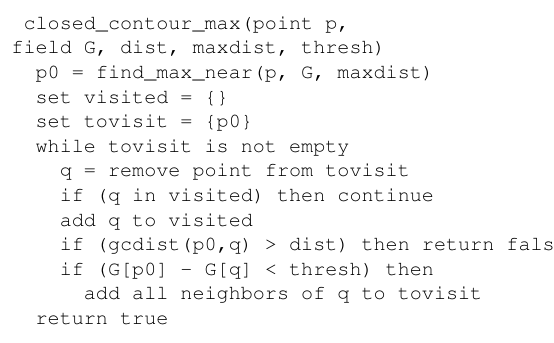
Algorithm 4 Find the node pmax containing the maximal